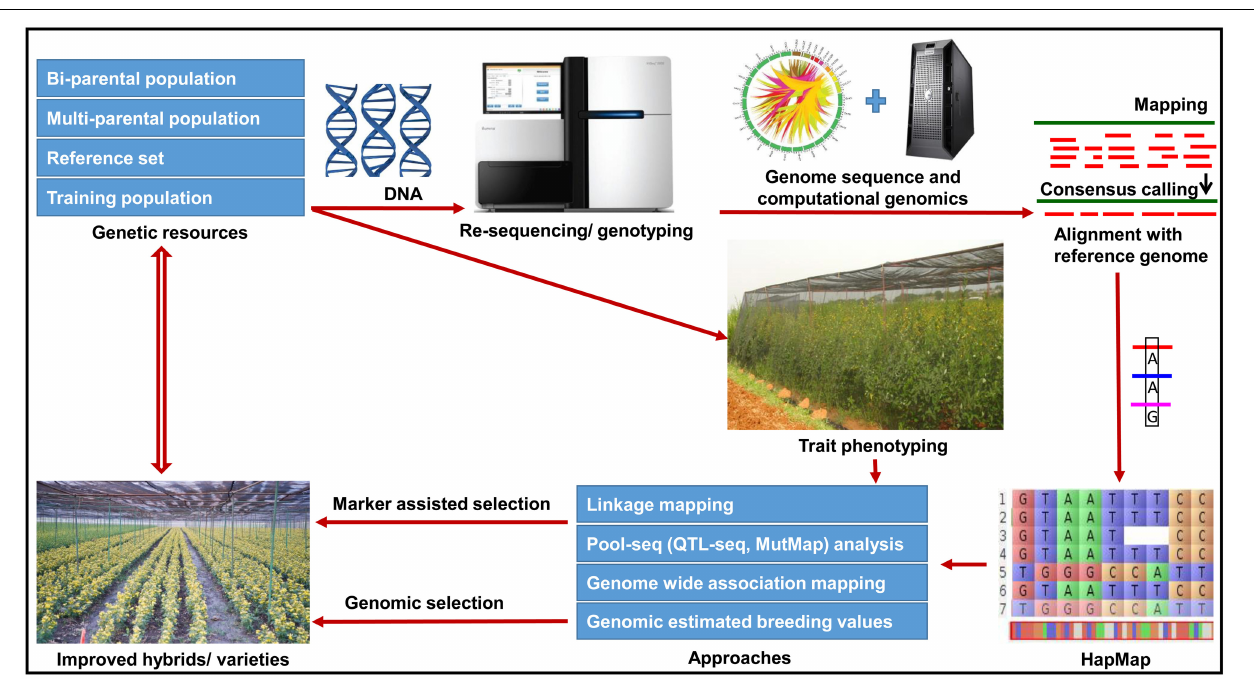
FIGURE 2 | Future directions for genomics-assisted breeding in pigeonpea. The figure illustrates a roadmap for the utilization of various genetic and genomic resources for deploying genomics-assisted breeding for